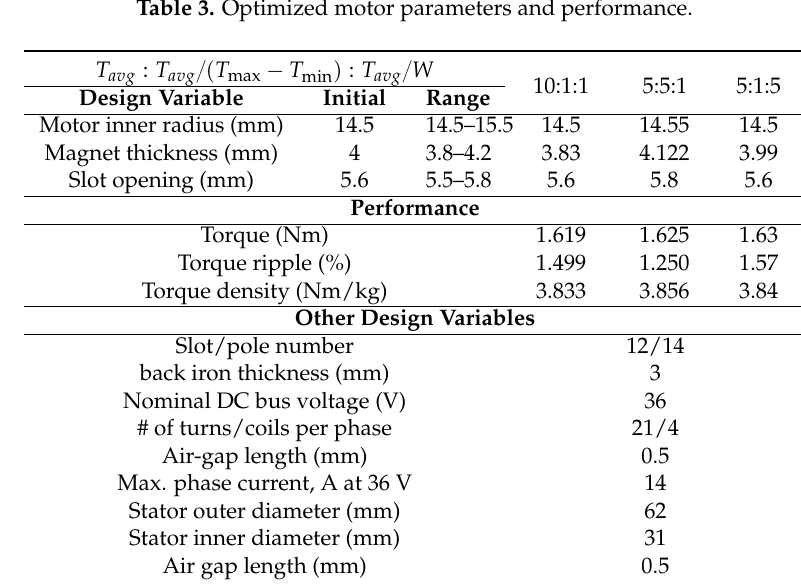
Table 3. Optimized motor parameters and